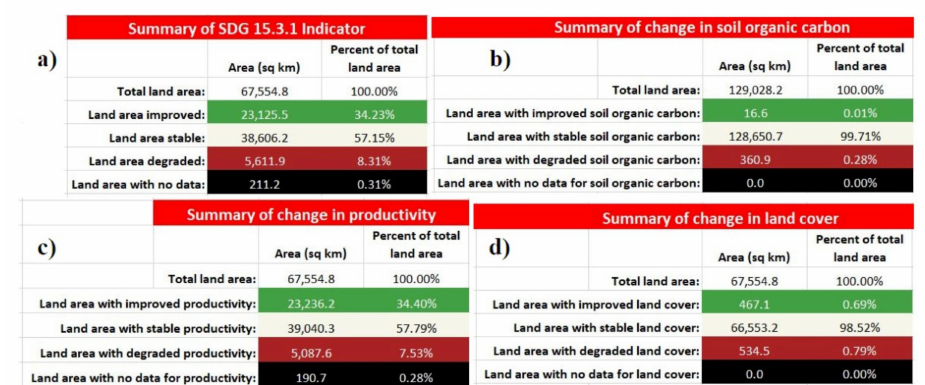
Figure 5. Indicative summaries of the results of SDG15.3.1 indicator, as produced by the Trends.Earth, using the same colours as the map of Figure 4b. ( a ) Overall statistics of the indicator, and statistics of changes in ( b ) SOC, ( c ) productivity, ( d ) land